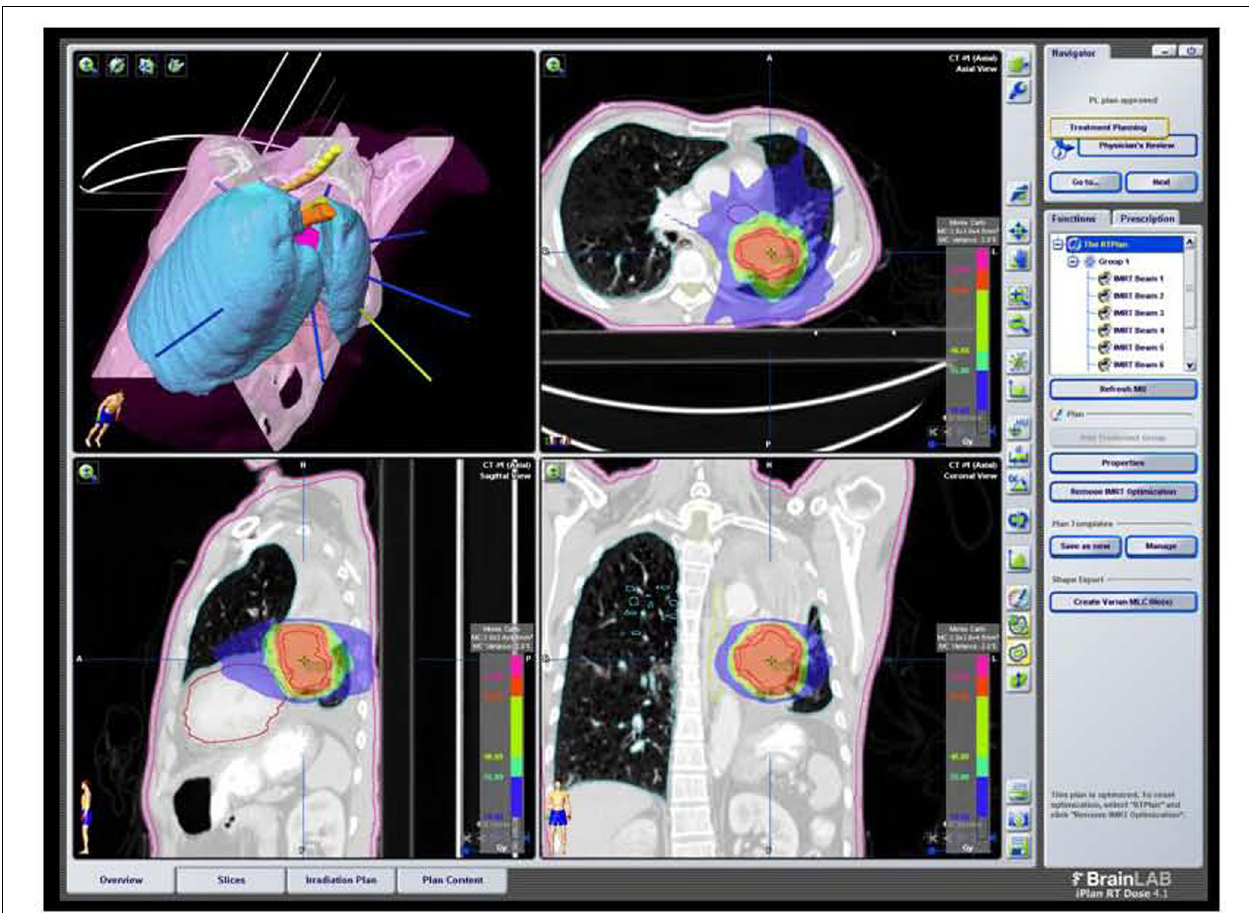
FIGURE 6 | SBRT dose wash for the same patient as Figure 2A with dose color wash [highest dose (50 Gy) in red delivered to the PTV]. Data courtesy of UCLA Radiation